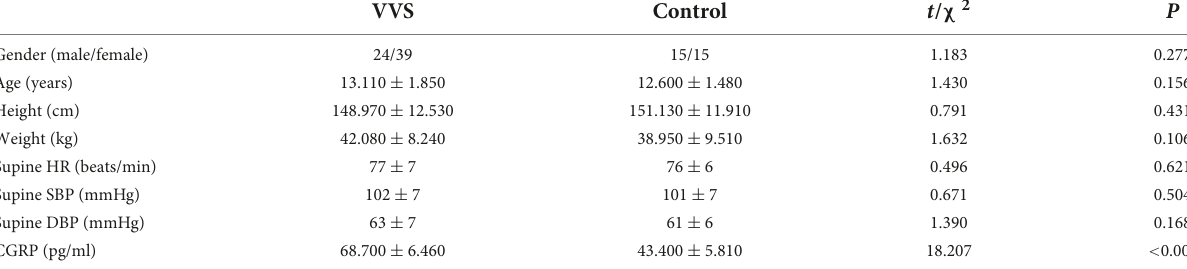
TABLE 2 Clinical features and hemodynamic data of VVS subjects and control subjects.